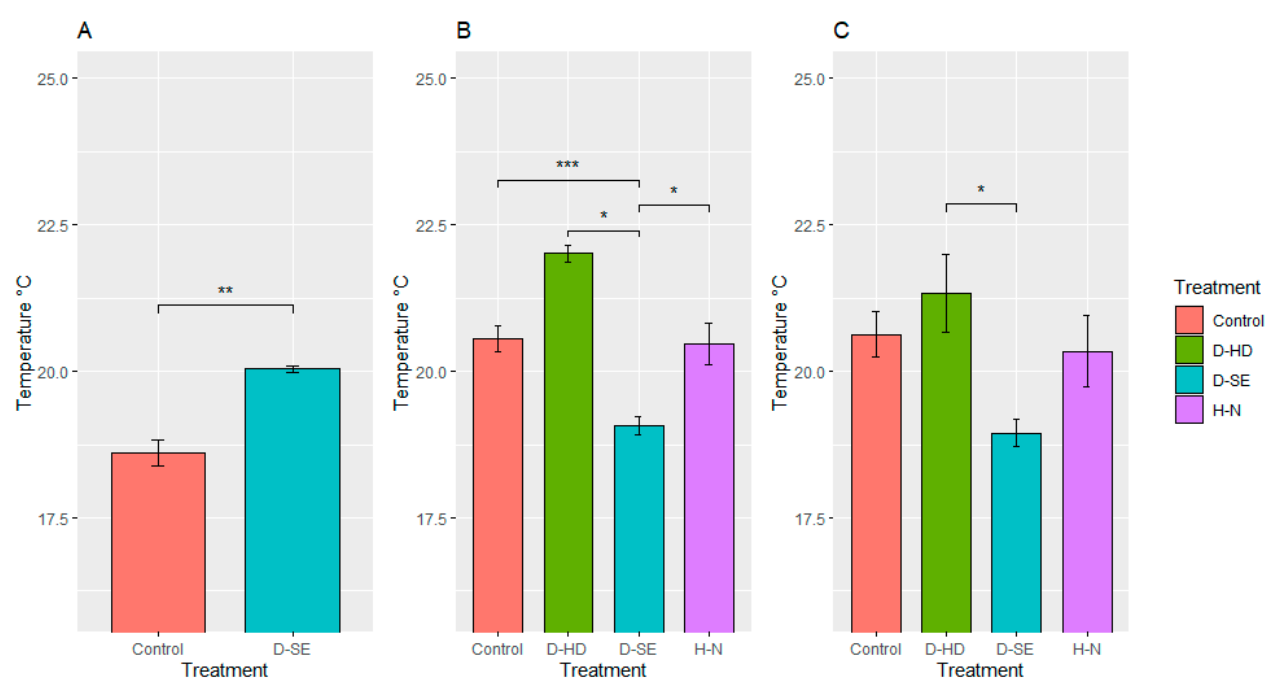
Figure 6. Plant growth pattern under different treatments, (control, drought at stem elongation (D_SE), drought at heading (D_H), and high nitrogen content (H_N)), from sowing to grain devel- opment. Pink arrow indicates when drought stress was induced, D_SE; dark cyan arrow indicates when drought stress was induced, D_H, and second nitrogen dosage was applied, H_N. The Y -axis represents the time points when the digital biomass was sampled and the X -axis represents the mean values of the obtained digital biomass. Error bars are standard error.